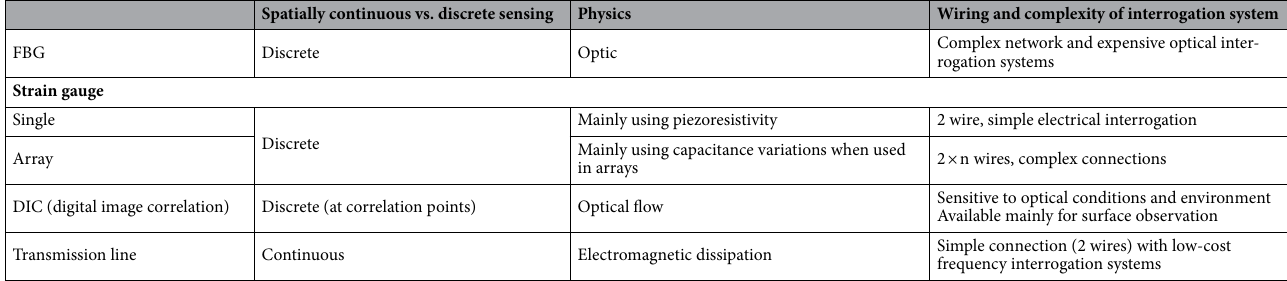
Table 1. Comparison between the main available distributed strain-sensing